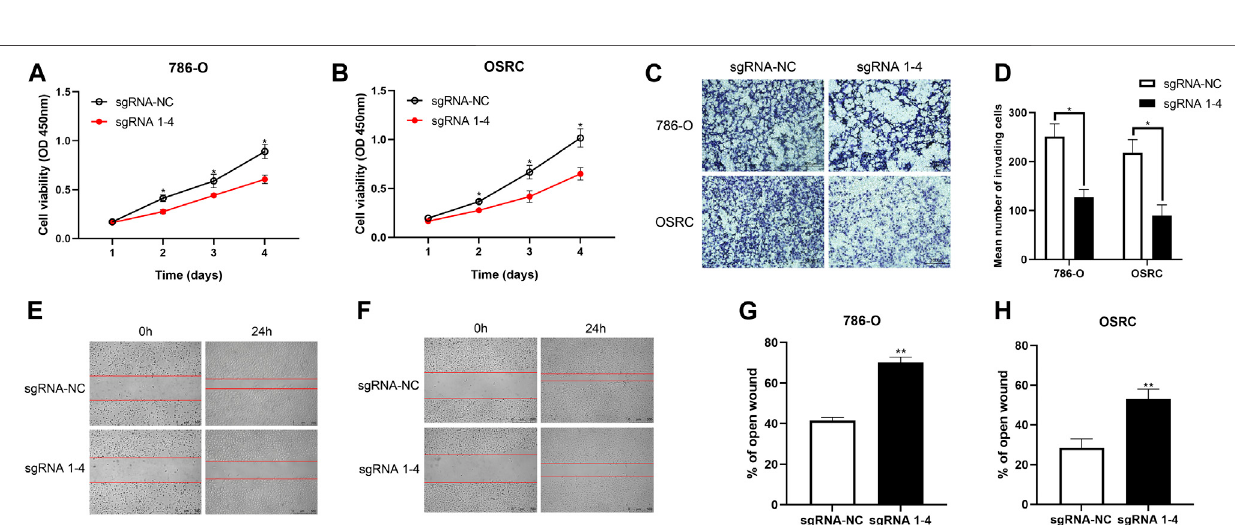
FIGURE 3 | TRIM58 targeted demethylation directly activates gene transcription. (A) Contruction of TRIM58-TET1 using CRISPR-dCas9 systems with 4 gRNAs targeting TRIM58 promoter region and the catalytic domain of DNA hydroxymethylase; (B , C) Bisul fi te clone-sequencing results from 786-O and OS-RC-2 cells transiently transfected with TRIM58-TET1; (D , E) TRIM58 gene transcription (D) and protein expression (E) following TRIM58-TET1 transfection.